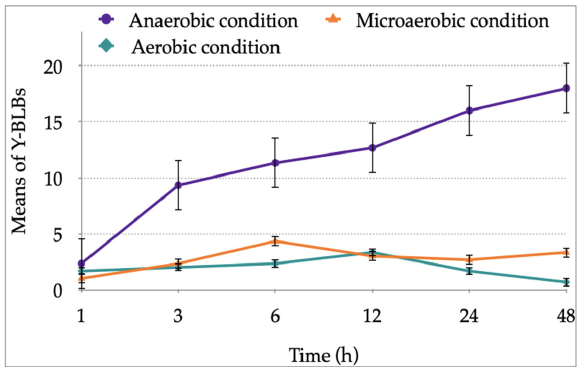
Figure 6. Means of yeast cells including bacteria-like bodies (Y-BLBs) found in the different co-cultures under the different incubation conditions. The higher means of Y-BLB percentages were reached at 24 h and 48 h of co-culture incubation under anaerobic conditions.